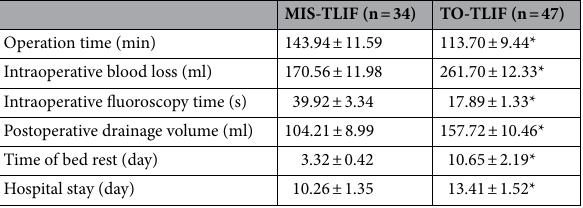
Table 2. Comparation of surgical indicators between the two groups (* P <